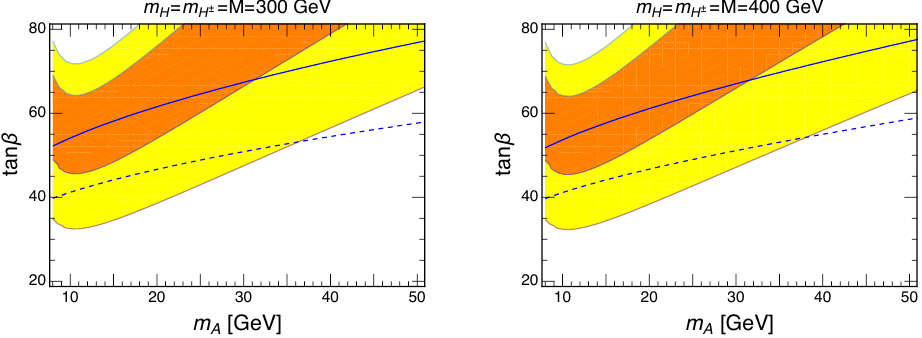
Figure 10 . The g (cid:0) 2 allowed regions with 1 (cid:27) C.L. (orange) and 2 (cid:27) C.L. (yellow) on the m A - tan (cid:12) plane vs. 95% C.L. and 99% C.L. upper limits denoted as the dashed and solid blue lines, respectively, from the lepton universality and (cid:28) decay